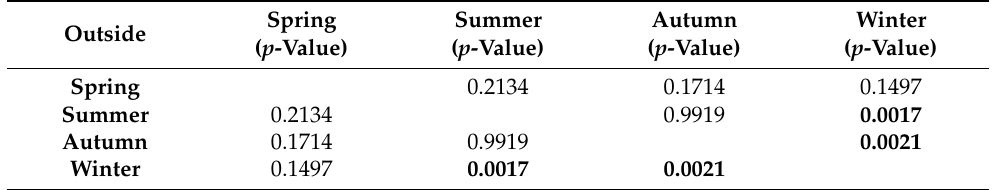
Table 1. Multiple comparisons (Steel—Dwass—Critchlow—Fligner post hoc test) of seasonal Basid- iobolus spp. counts in gecko droppings collected from the